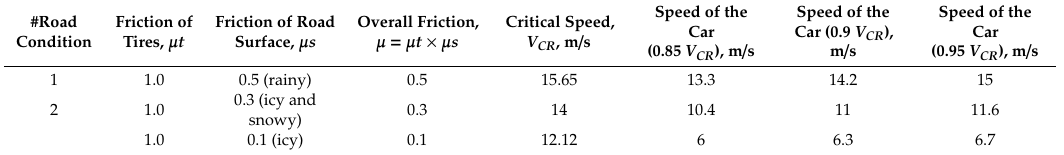
Overall Friction, µ = µ t × µ s